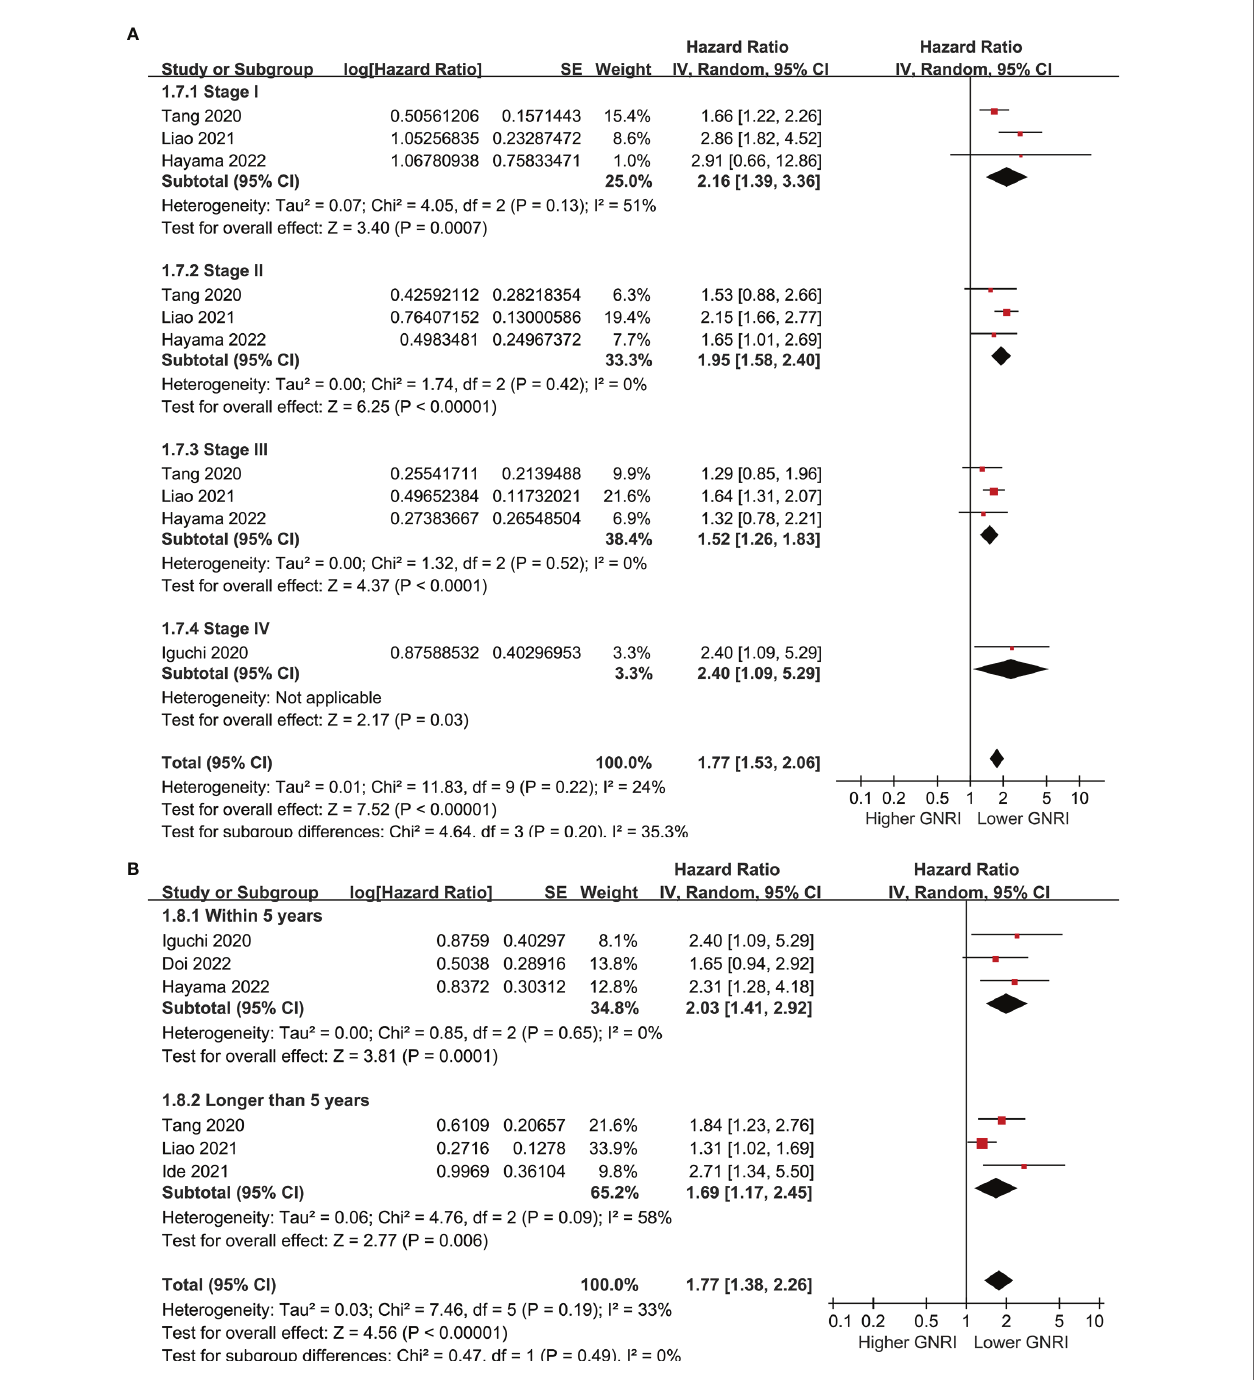
FIGURE 5 | Forest plots for the subgroup analysis regarding the association between GNRI and PFS in patients with CRC; (A) subgroup analysis according to the stage of cancer; and (B) subgroup analysis according to the follow-up